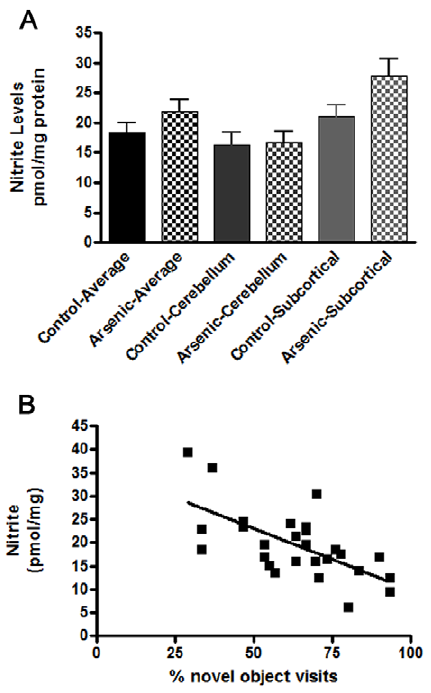
Figure 5. Nitrite levels in cerebellum and subcortical areas of mice exposed to arsenic. A . Nitrite levels were measured by tri- iodide based reductive chemiluminescence as in Curtis et al. [62] and presented as pmol/mg of protein. The average nitrite levels in cerebellum or subcortical tissue represent values relative to total nitrite levels in the brain. Although comparisons between control and arsenic samples (average total, cerebellum or cortical) indicate no significant changes, there is a strong trend towards an increase. B . A negative correlation between nitrite levels in arsenic treated mice and cognitive performance assayed by novel object recognition. The average nitrite concentration was correlated to the % novel object visits for control and arsenic mice (r 2 = 2 0.4138, p , 0.001). Control n=14, arsenic